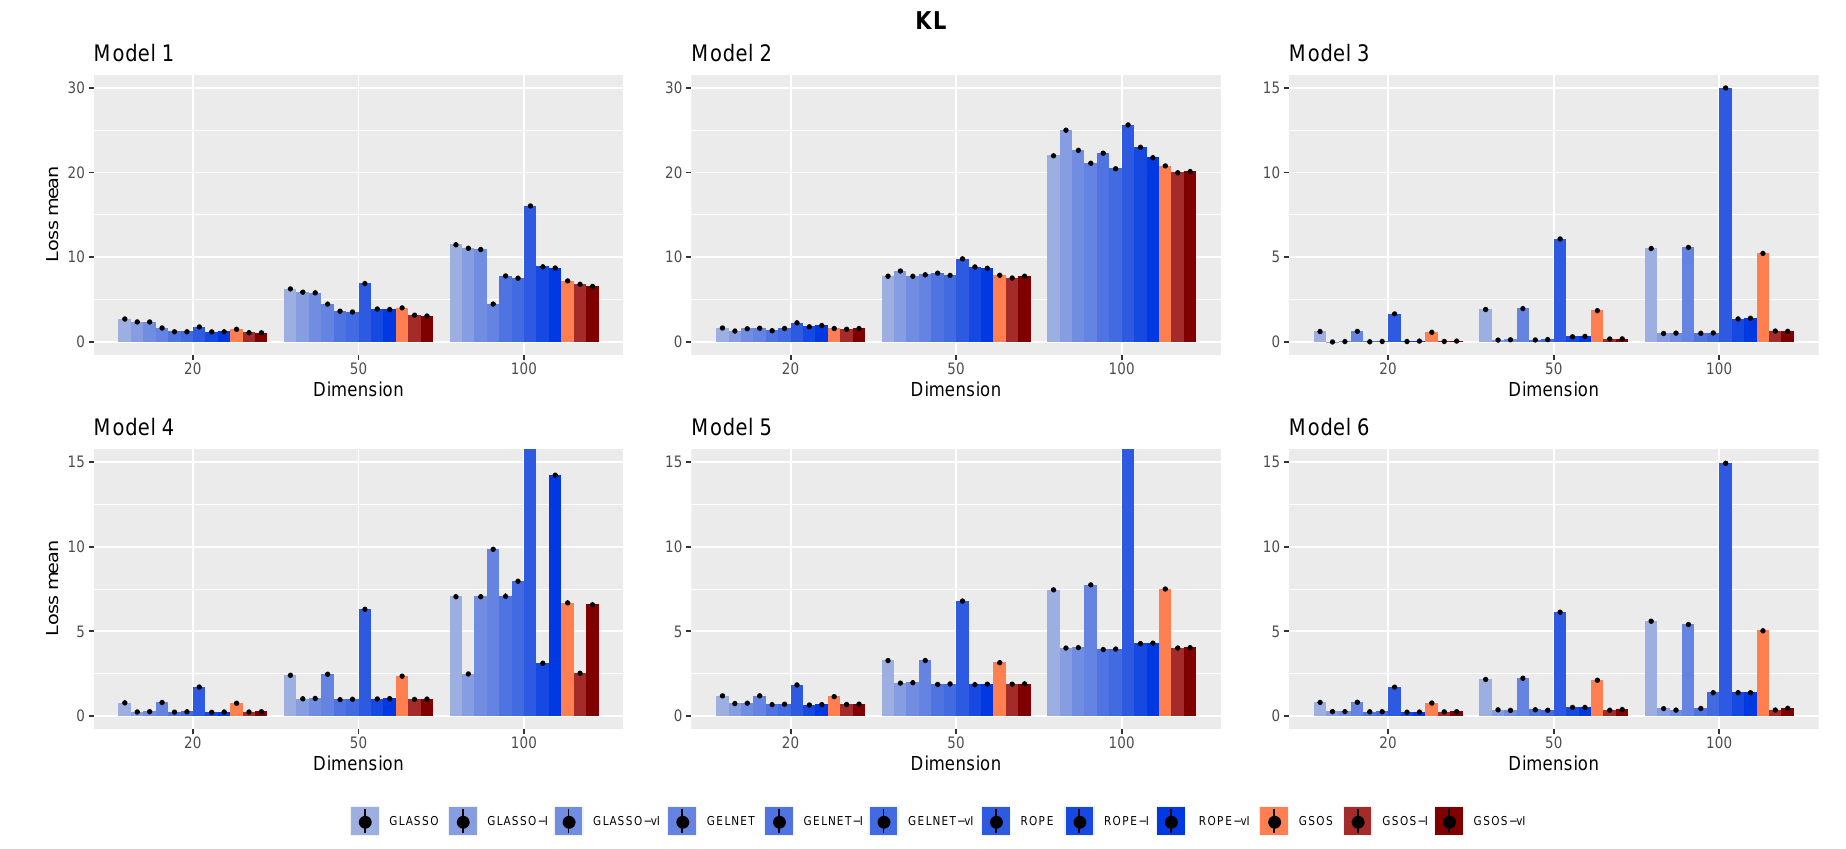
Figure 1. The mean of Kullback–Leibler loss for the different models and methods based on 100